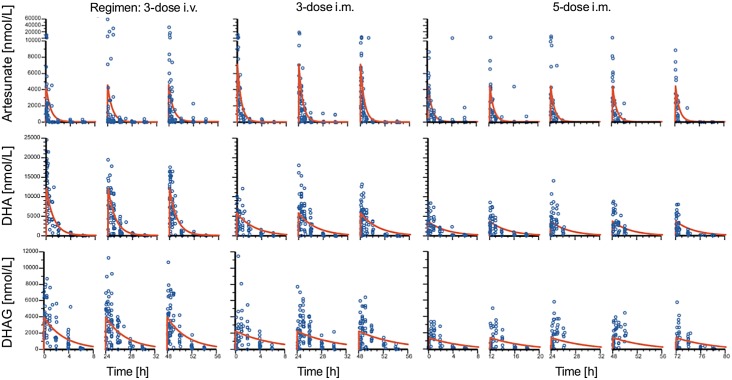
Population pharmacokinetic profiles of artesunate, dihydroartemisinin, and dihydroartemisinin glucuronide.Plots of observed concentration–time profiles for ARS and its major metabolites, DHA and DHAG, are presented according to treatment regimen. Estimated population mean PK profiles are shown by red lines. The three columns of results for each regimen represent the findings after each dose.